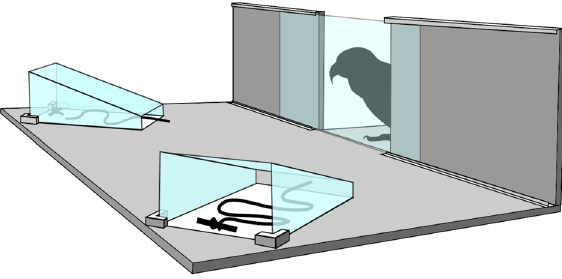
Figure 1. Diagram of setup used in Experiment 1, where kea had to choose between a continuous and a broken string, both of which were placed under sloping acrylic shields and were attached to rewarding black